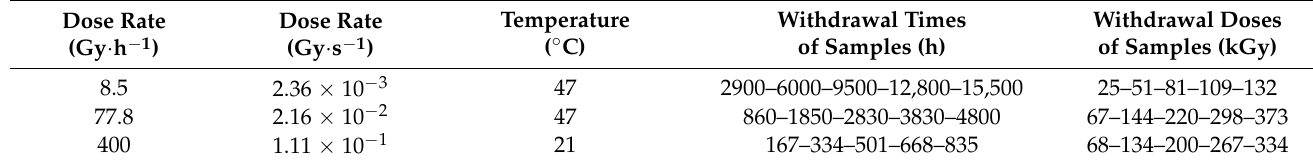
Table 2. Radio-thermal ageing conditions.